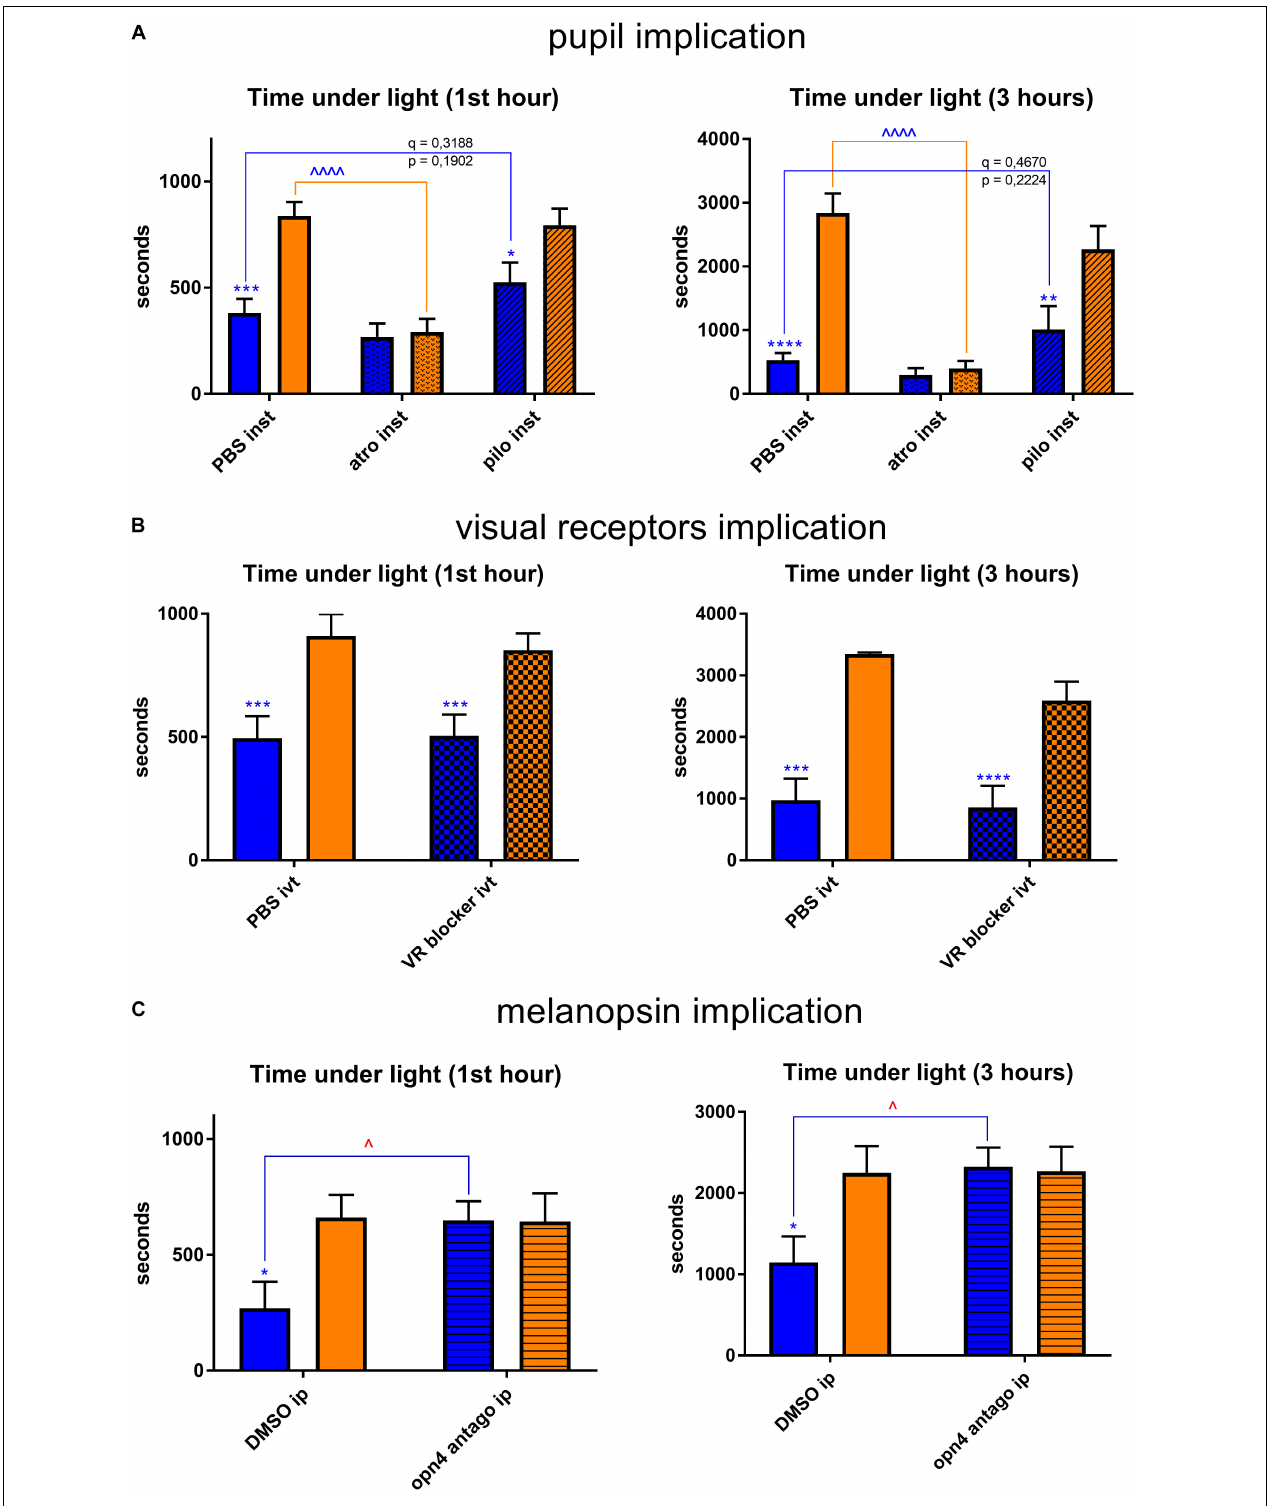
FIGURE 6 | Retina-related behavioral tests. Graphs illustrate the time spent in the illuminated part of the box during the chosen representative periods. For more detail, see “Materials and Methods” section. (A) Pupils were dilated with atropine ( atro ) or constricted with pilocarpine ( pilo ). One drop per eye was instilled ( inst ) bilaterally 5 min before the start of light exposure (1st hour: PBS blue vs. yellow – q = 0.0004, p = 0.0003; pilo blue vs. yellow – q = 0.0057, p = 0.0108;